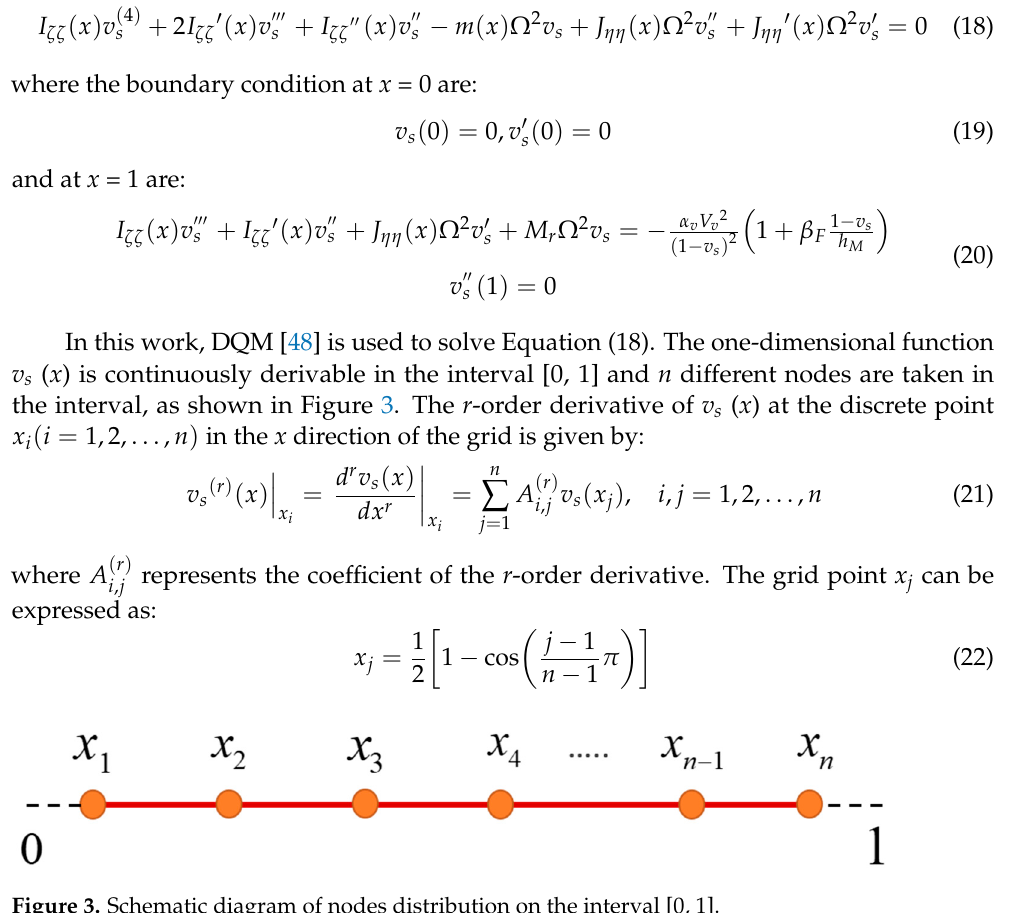
Figure 3. Schematic diagram of nodes distribution on the interval [0, 1].